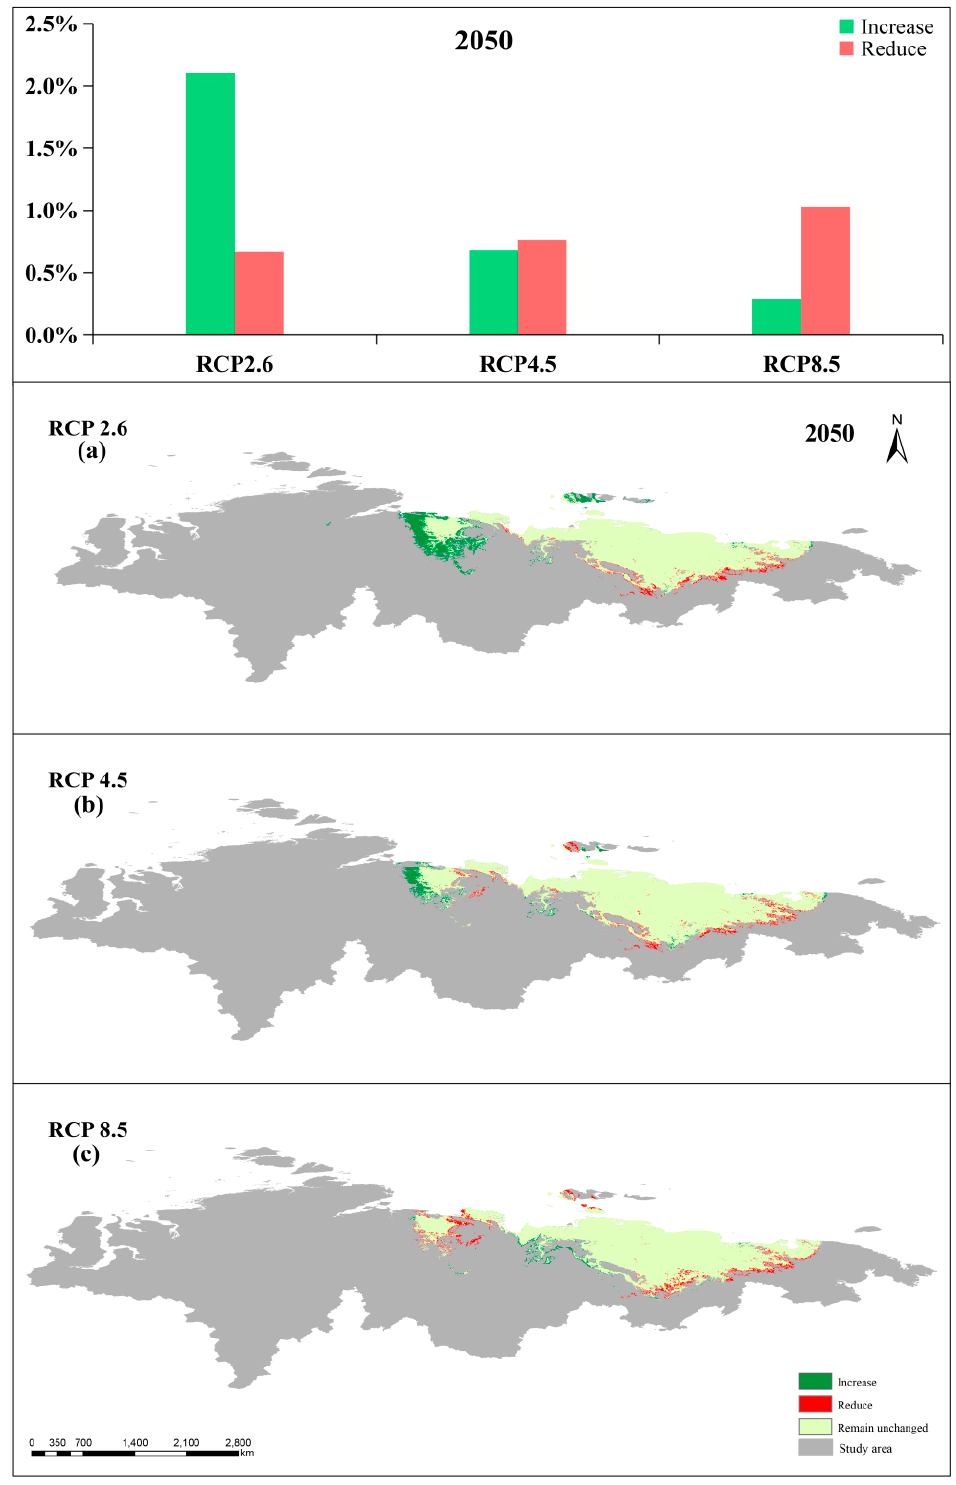
Figure 8. Increases and decreases in suitable breeding sites for lesser white-fronted goose under different climate change scenarios in 2050: ( a ) 2.10% increase and 0.67% decrease under the RCP2.6 scenario; ( b ) 0.68% increase and 0.76% decrease under the RCP4.5 scenario; and ( c ) 0.29% increase and 1.03% decrease under the RCP8.5 scenario. Red indicates the decreased area, and green represents the increased area.